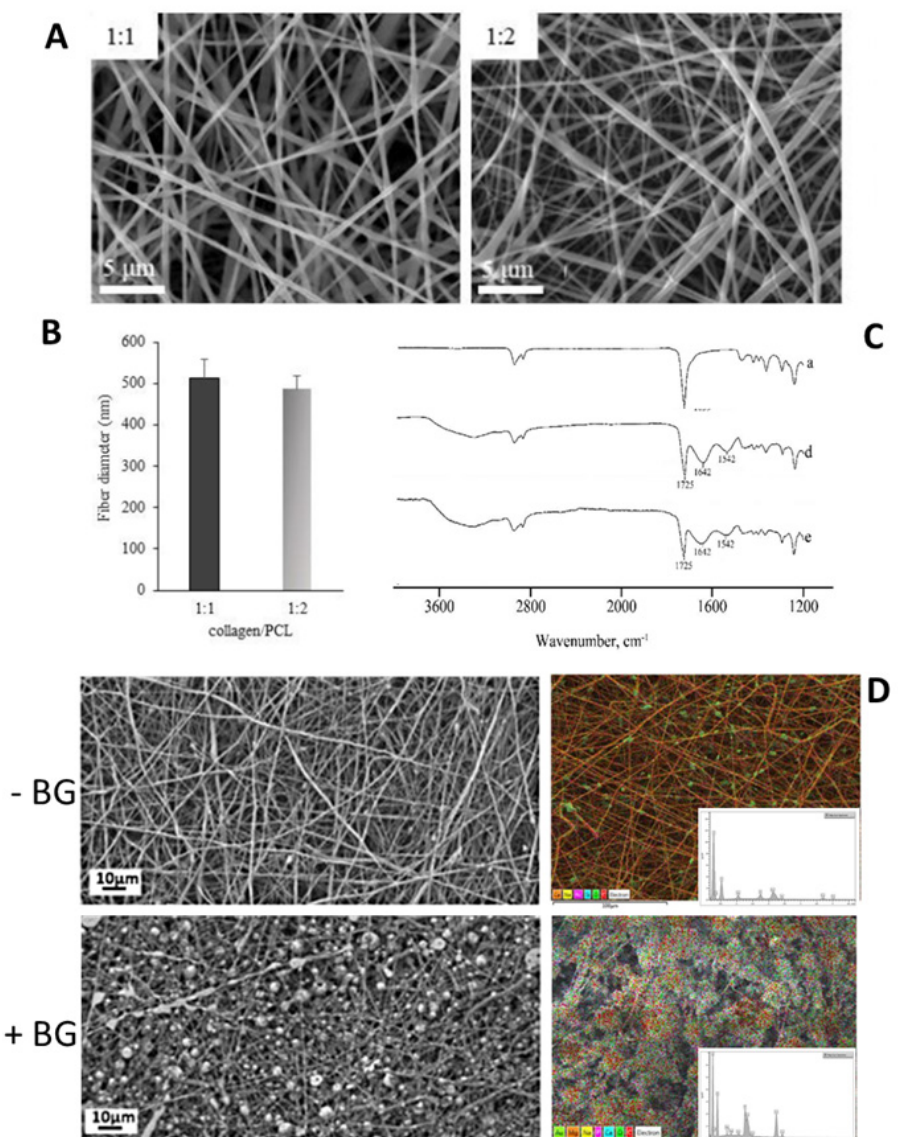
Figure 3. Composite ( A – C ) and blended ( D ) PCL-based fibers via green solvent electrospinning: ( A ) qualitative morphological analysis via SEM, ( B ) quantification of 1:1 and 1:2 PCL/Collagen blended nanofibers, and ( C ) FTIR analysis; ( D ) SEM and EDS spectra with element mapping of PCL/BG nanofibers [20,76]. (images from [20,76] with free license).